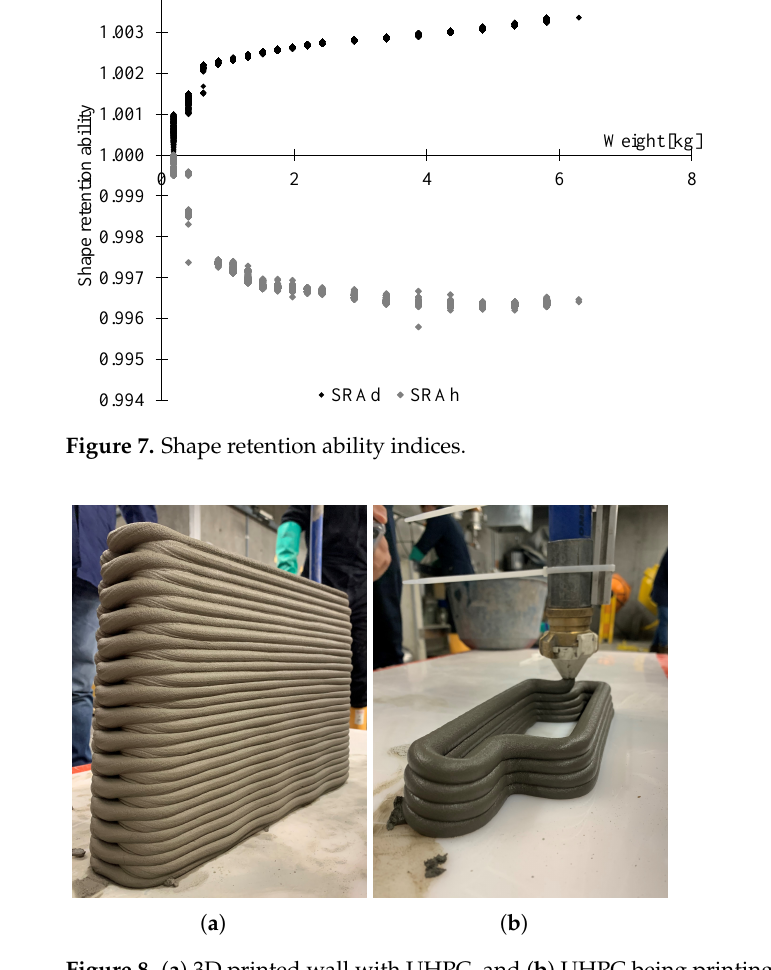
Figure 8. ( a ) 3D printed wall with UHPC, and ( b ) UHPC being